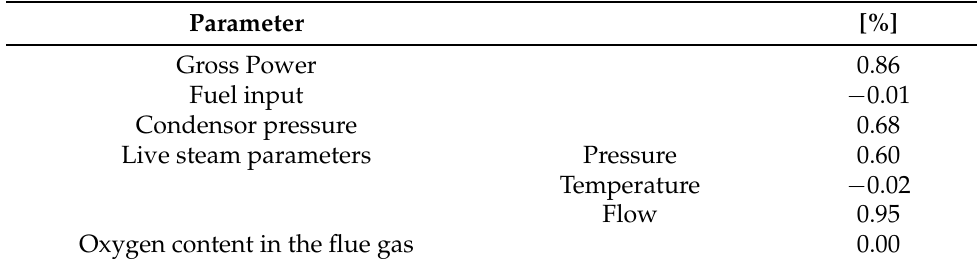
Table 2. Deviation between the model and the acceptance